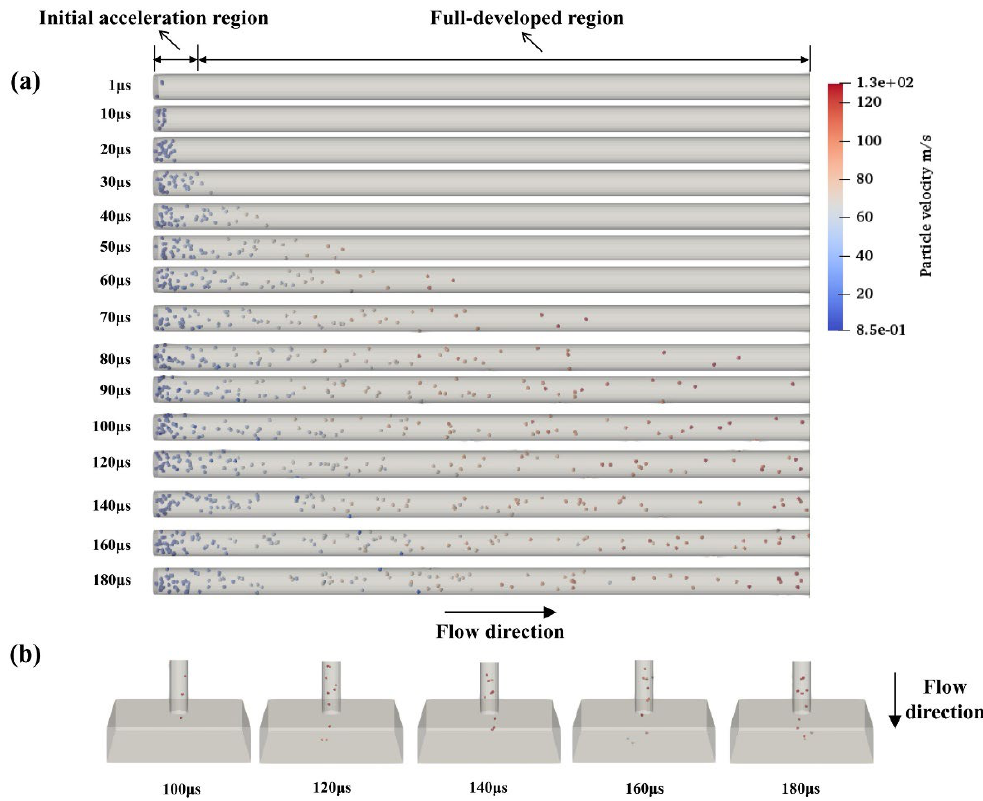
Figure 21. Evolution of particle jet flow along the jet flow direction in the AAJ micromachining. ( a ) The flow pattern inside the AAJ nozzle and ( b ) the particle distribution after the particles leave the nozzle exit [133].